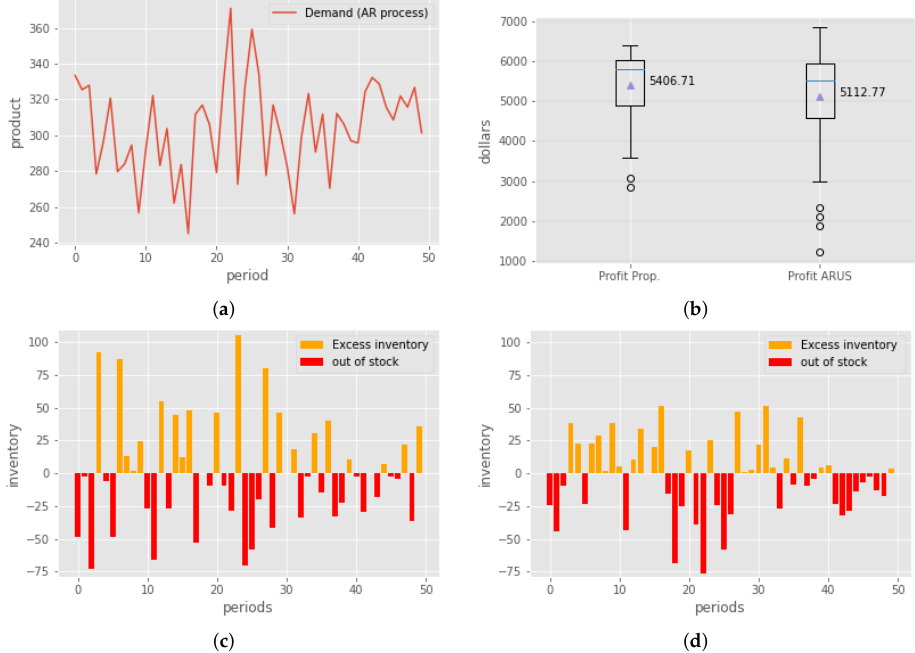
Figure 2. ( a ) AR process as demand, ( b ) profit boxplot of ARUS and proposed method, ( c ) ARUS inventory, and ( d ) proposed method inventory.